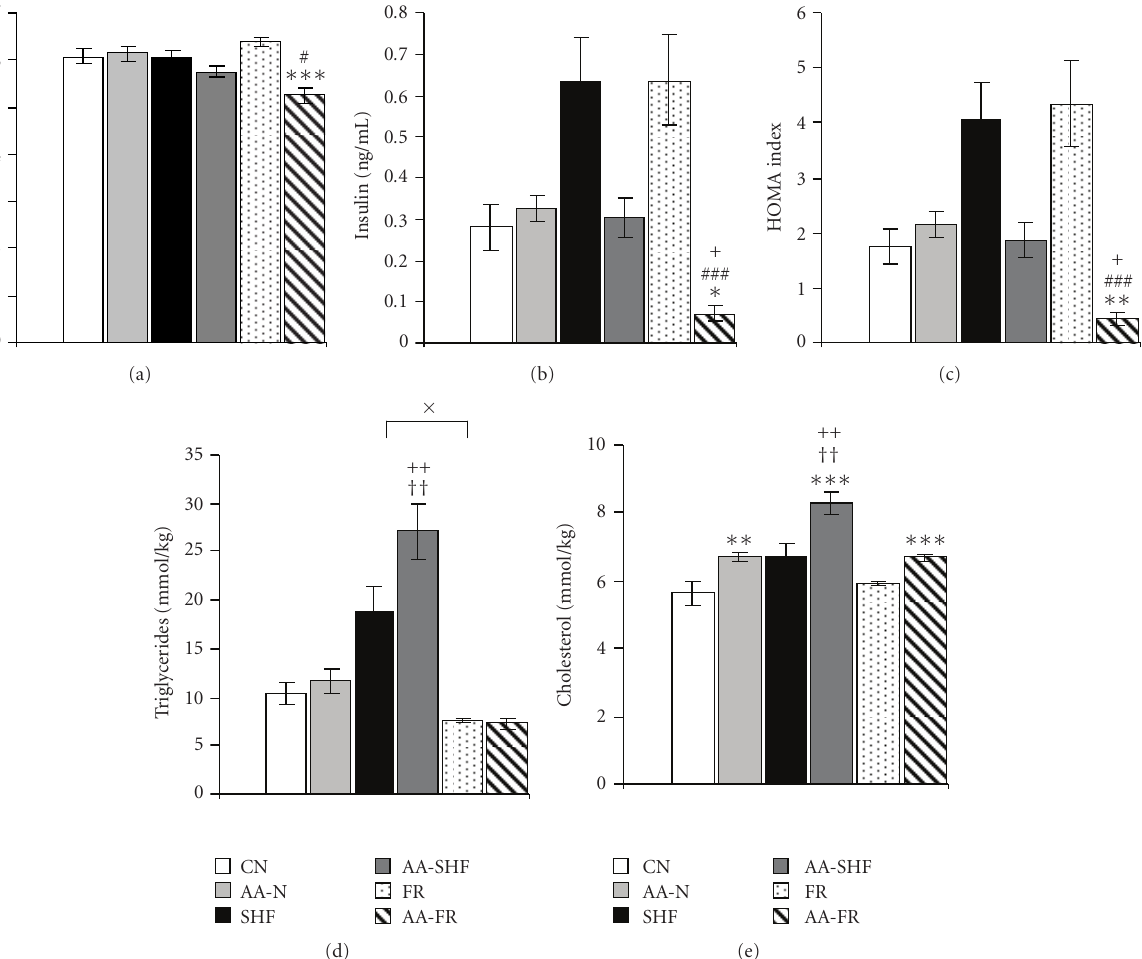
Figure 5: Basal plasma levels of glucose (a) and insulin (b), HOMA index (c), and liver concentrations of triglycerides (d) and cholesterol (e) in healthy controls (CN, SHF, FR) and arthritic rats (AA-N, AA-SHF, AA-FR) on day 18 after cFA inoculation. Results are expressed as means ± SEM. Significant di ff erence between healthy controls on di ff erent dietary regime: × P < . 05. Significant di ff erences between control rats and arthritic rats on the same dietary regime: ∗ P < . 05, ∗∗ P < . 01, ∗∗∗ P < . 001. Other statistical di ff erences: AA-FR versus AA-N # P < . 05, ### P < . 001; AA-FR versus AA-SHF + P < . 05, ++ P < . 01; AA-SHF versus AA-N †† P < . 01. For abbreviations see Figure